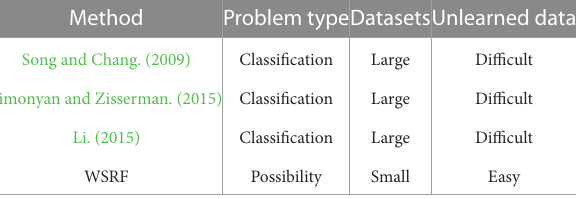
TABLE8 Resultsforclassificationindifferentmethods.